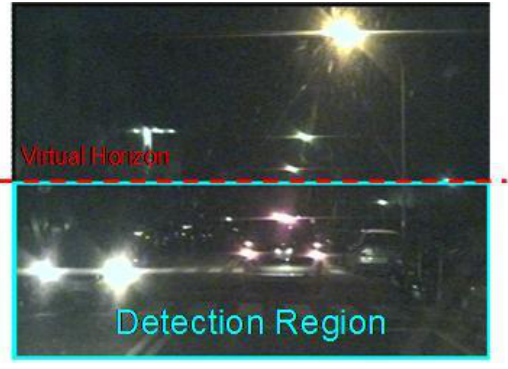
Figure 4. The detection region and virtual horizon for bright object extraction in Figure 2.